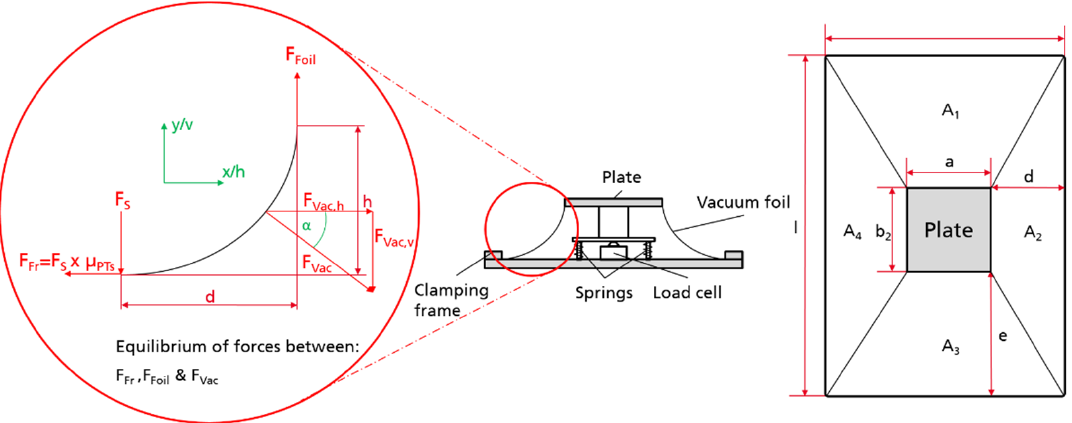
Figure 18. Side view of the test stand and acting forces and top view of the test stand.